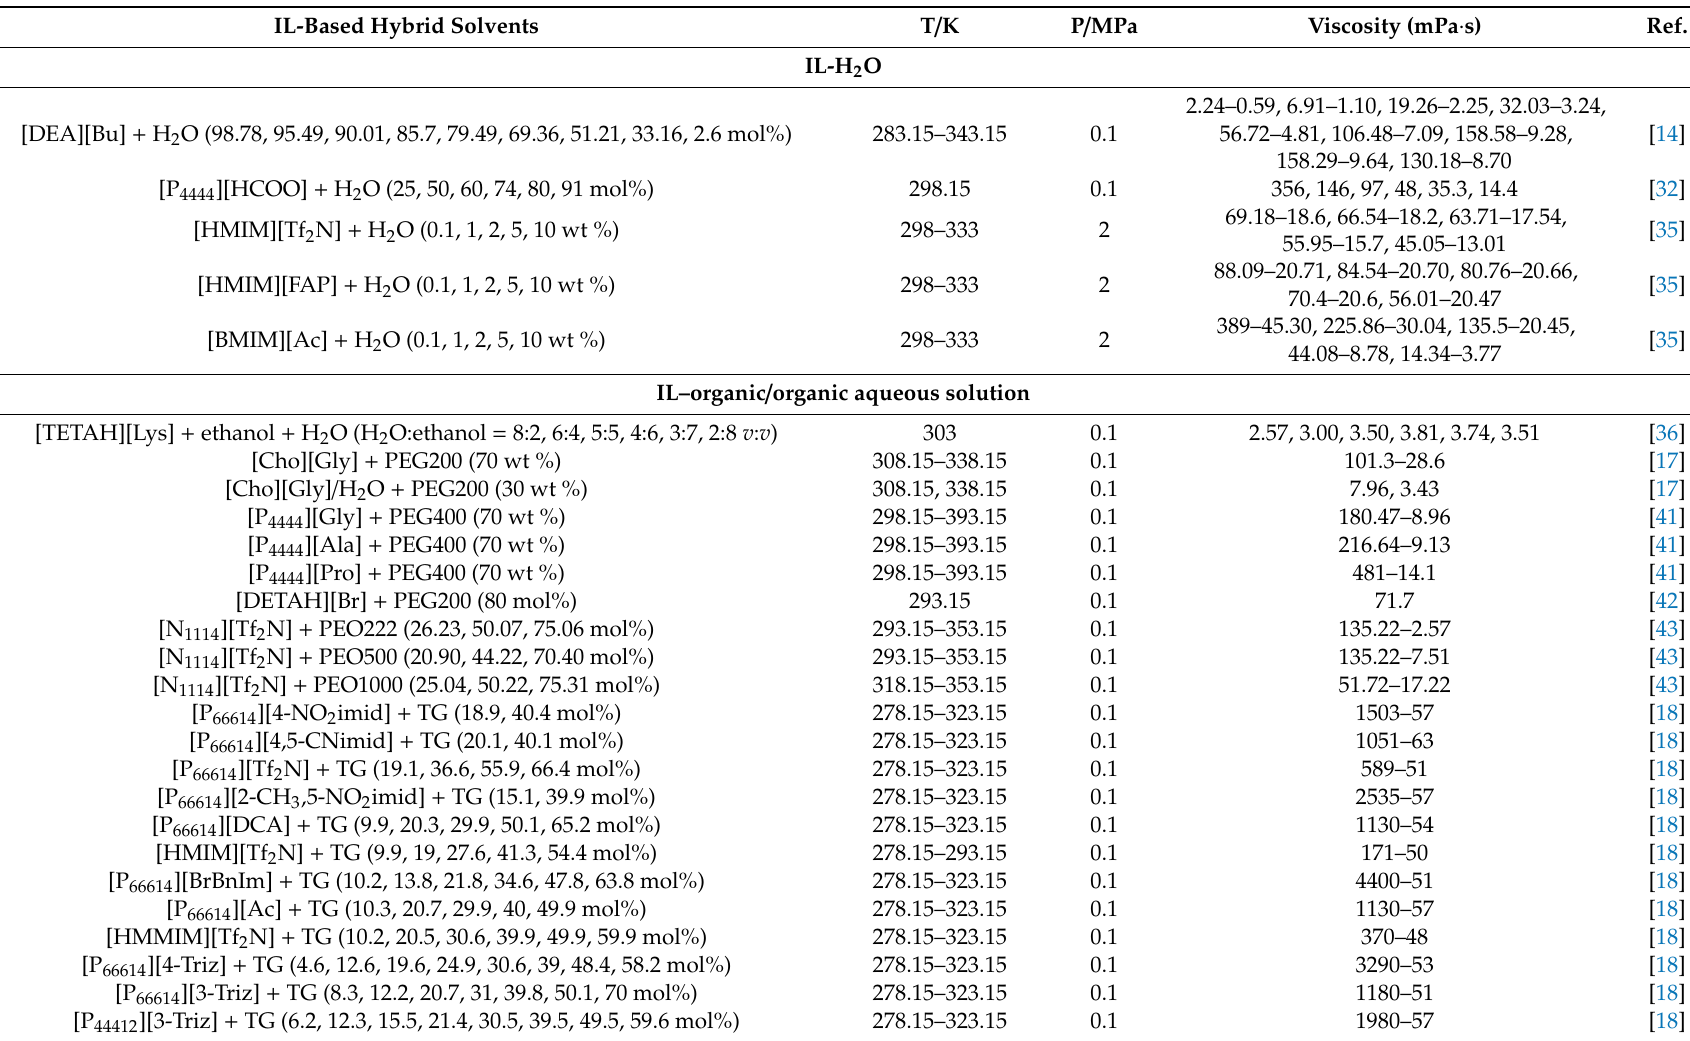
Table 3. Viscosity of IL-based hybrid